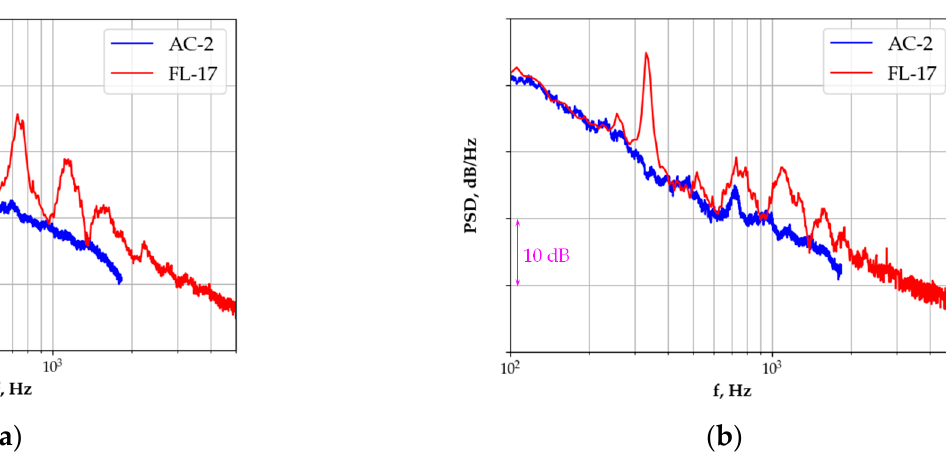
Figure 18. Comparison of the normalized spectra of the two-wheel landing gear model with high main leg. Microphone is at ( θ , φ ) = (90°, 20°). Flow speed is ( a ) 75 m s − 1 , ( b ) 34 m s − 1 .